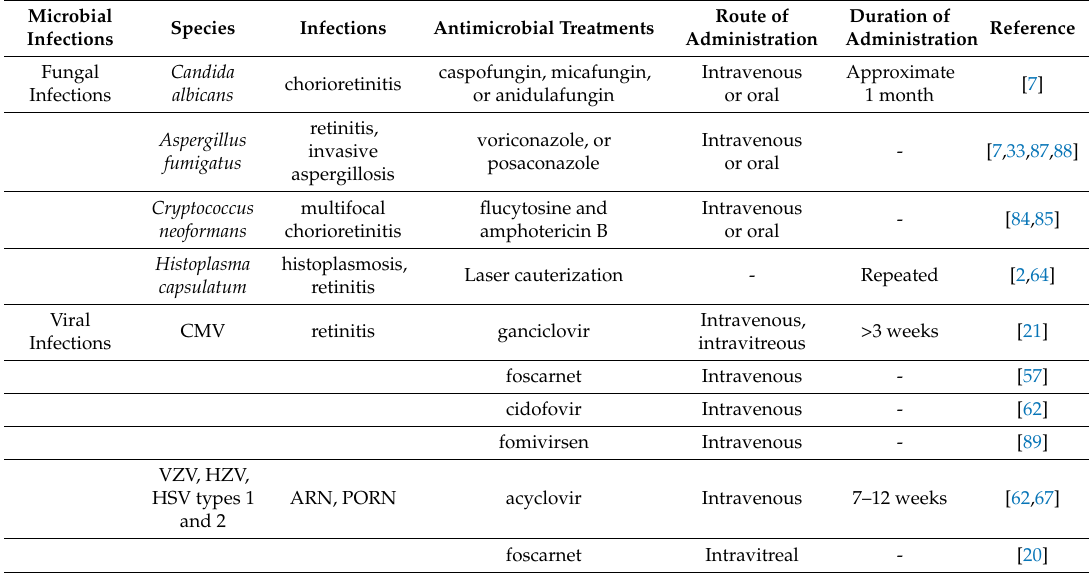
Table 1. The causative agents of ocular microbial infections, antimicrobial treatments, route and duration of